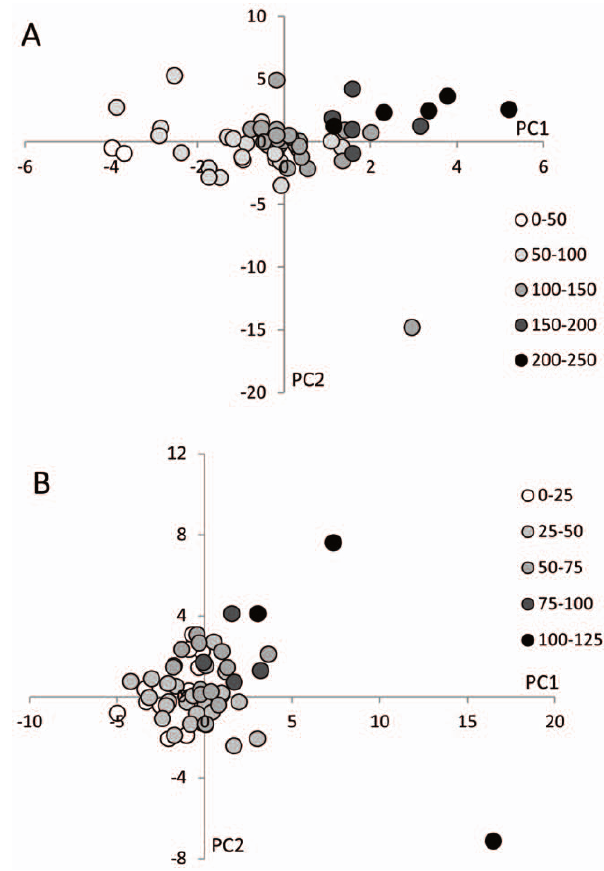
Figure 5. Score plots showing clustering of the metabolite profiles analyzed using PLS-DA according to genotoxicity (A) and cytotoxicity (B). (A) High genotoxicity samples are located on the right side of the score plot, while low genotoxicity samples are present on the left side, indicating a difference in VOC profile between high and low genotoxicity samples. (B) High cytotoxicity samples are present on the upper right side of the score plot and low cytotoxicity samples on the lower left side, indicating a difference in VOC profile between high and low cytotoxicity samples.